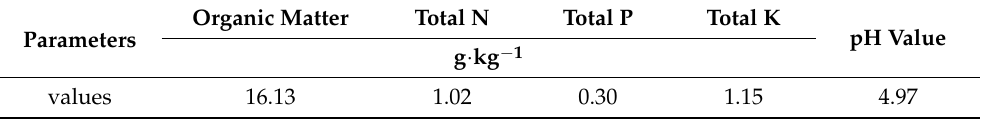
Table 2. Some important physicochemical properties of soil used in the